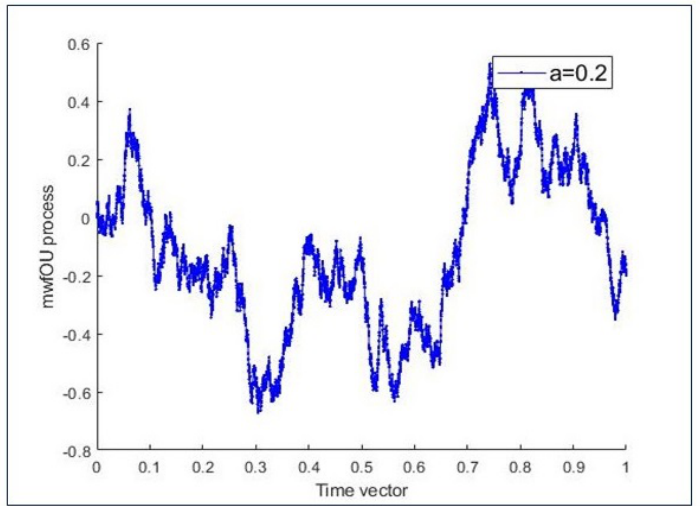
Figure 2. Simulation of sample paths of mwfOU process for small parameter